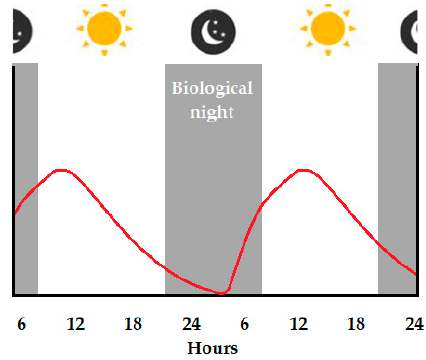
Figure 12. 4/8 Program Watch Rotation and Daily Routine [41]. Figure 13. Normal work and rest schedule, ( ▬ ) = work [42].